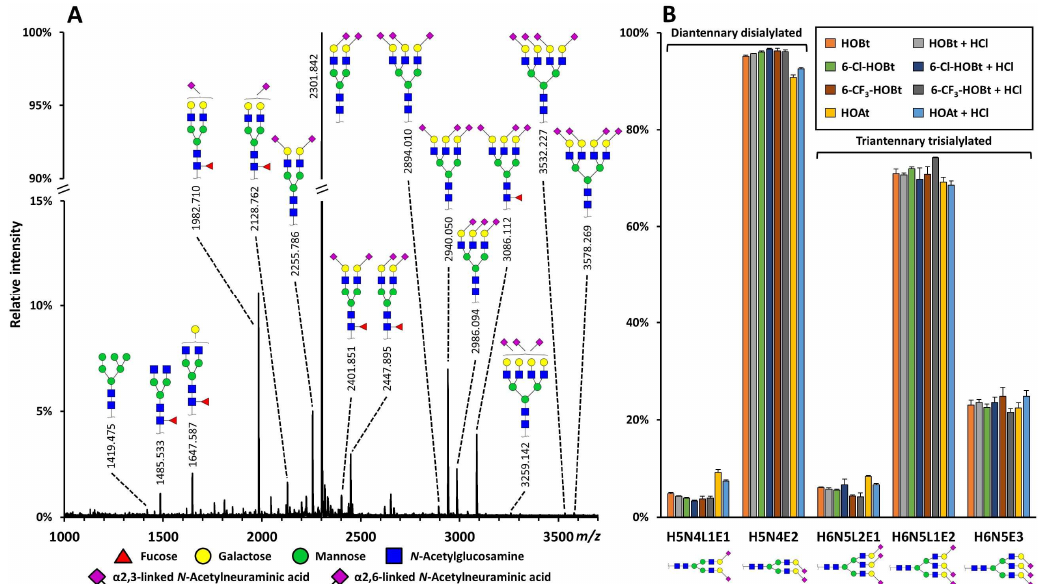
Figure 5. Representative MALDI-TOF-MS spectrum of derivatized N -glycans released from total plasma (TPNG) using 6-Cl-HOBt as catalyst at native conditions, and linkage-specificity of the reaction conditions as determined on a TPNG sample. ( A ) Mass spectrum showing relative intensities from m/z 1000 to 3700. Compositional assignments were based on accurate mass and isotopic pattern matching, structural assignments were based on literature and biosynthetic pathways. Except for the N -acetylneuraminic acids, glycosidic linkages were not determined. The assigned glycan signals had a signal-to-noise (S/N) > 9. Different sialic acid linkages are indicated by a left (α2,3) or right (α2,6) angle. ( B ) Relative ratio of di- and triantennary sialylated species with the gross composition hexose (H)5; N -acetylhexosamine (N)4; N -acetylneuraminic acids (S)2; and H6N5S3 and their different sialic acid linkage variants (lactonized α2,3-sialic acid: L; ethyl esterified α2,6-sialic acid: E) after incubation with the di ff erent catalysts under native and acidic pH at 37 ◦ C. Note: the di- and triantennary glycans are total area normalized to 100% separately. Error bars represent SD for triplicate